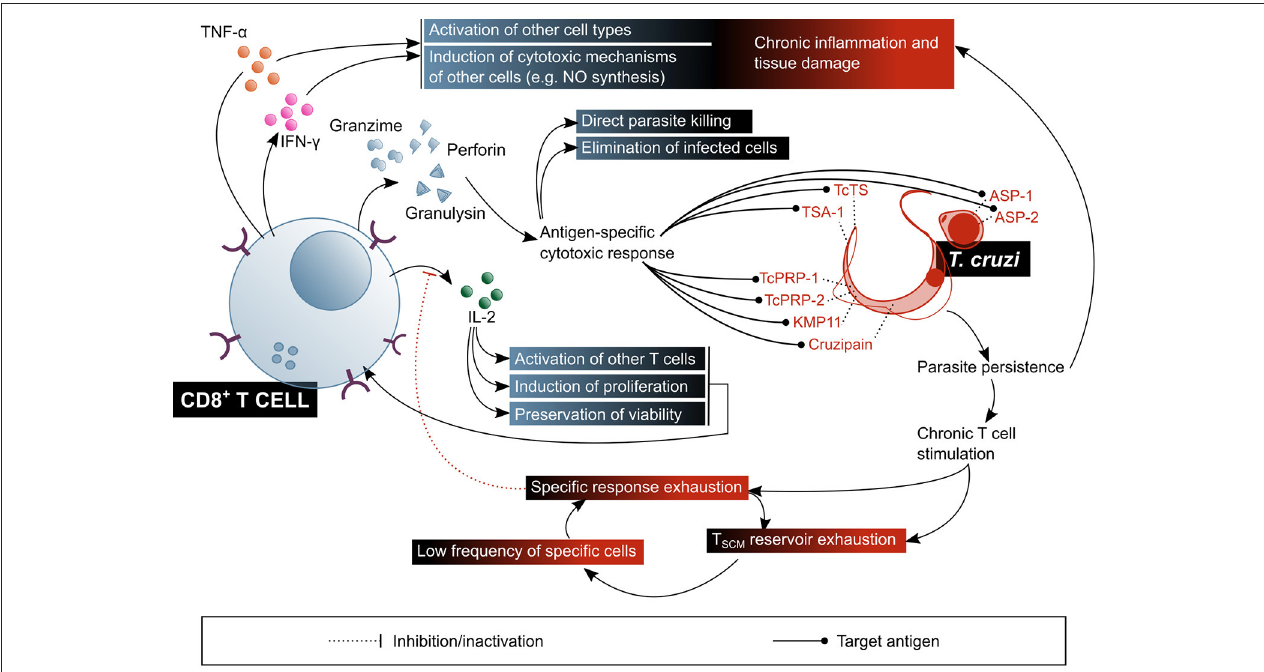
FIGURE 6 | CD8 + T lymphocytes play a fundamental role in the control of parasitaemia and the elimination of cells infected with T. cruzi , but their chronic stimulation impairs their function. In addition, CD8 + T cells are involved in the pathogenic inflammatory processes of Chagas disease. The beneficial factors for the host are highlighted in blue shaded boxes, while the factors considered harmful to the host are shown in red shaded boxes. ASP, amastigote surface proteins; TcTs, T. cruzi transialidase; TcPRP, T. cruzi paraflagellar rod protein; KMP11, kinetoplastid membrane protein 11; TSA-1, trypomastigote surface